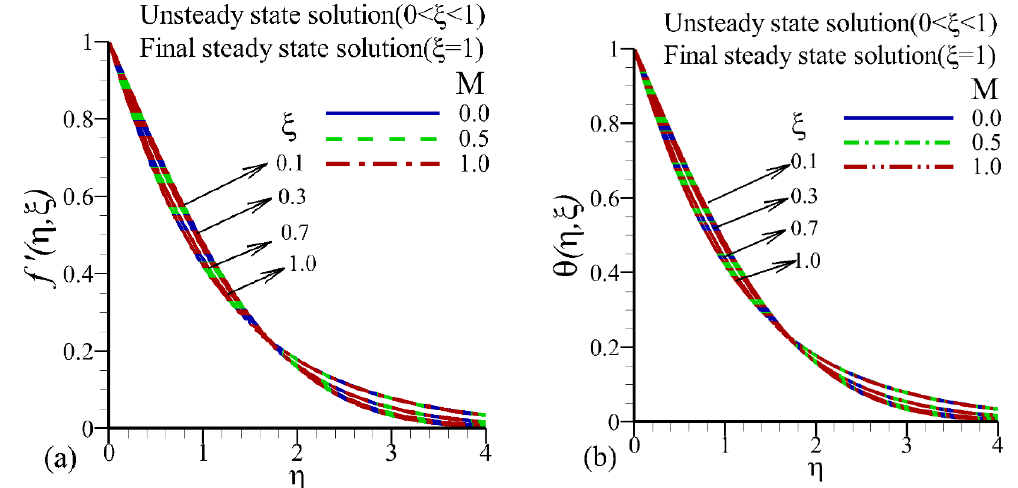
Figure 9. ( a ) Velocity f (cid:48) ( η , ξ ) , ( b ) Temperature θ ( η , ξ ) against η for M = 0.0,1.0, and 2.0, ξ = 0.1,0.3,0.7,1.0, while R d = β = 0.5 and Pr = λ = 1.0.